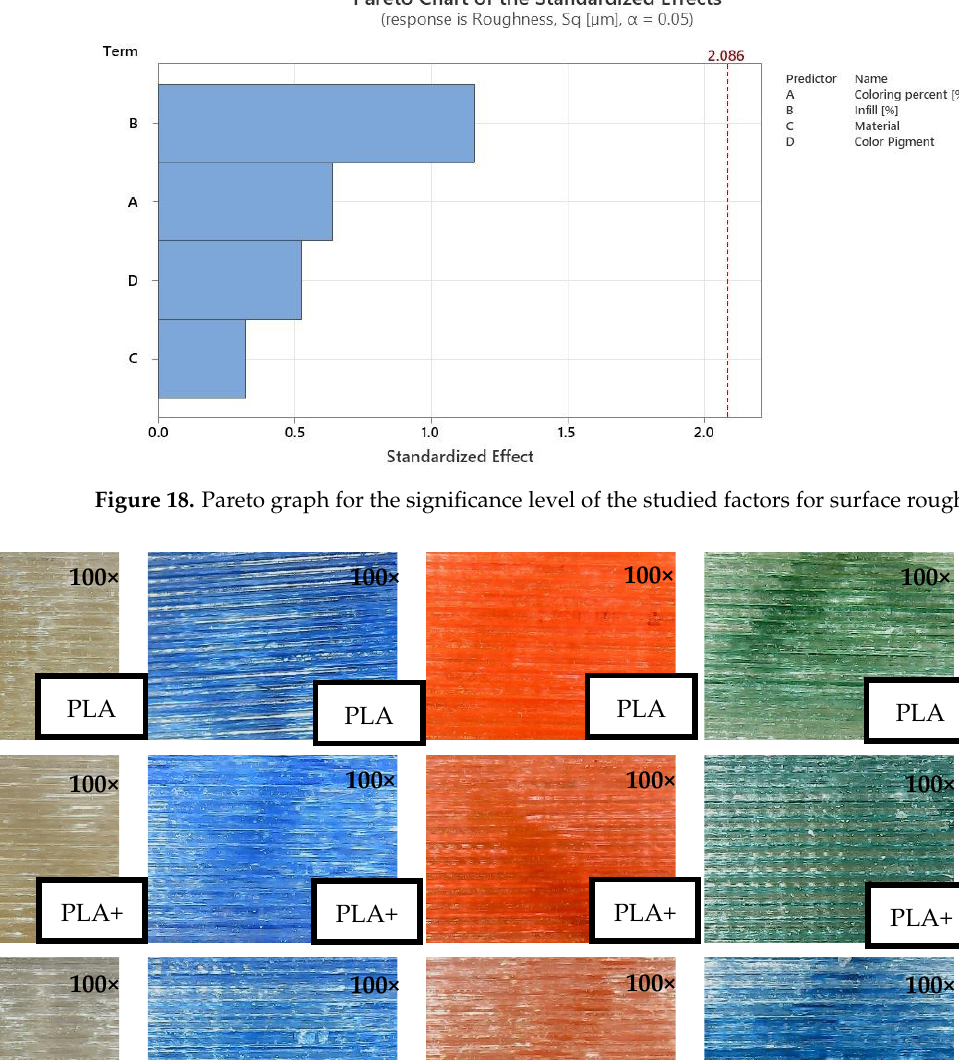
Figure 18. Pareto graph for the significance level of the studied factors for surface roughness.